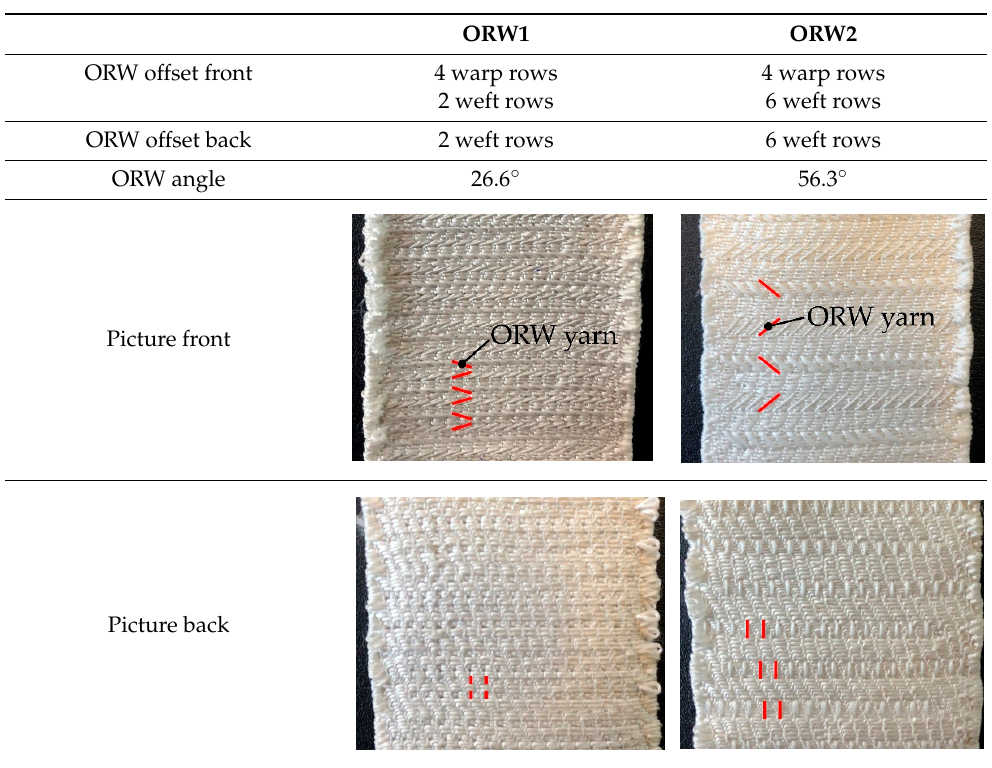
Table 2. Overview of open reed weaves.